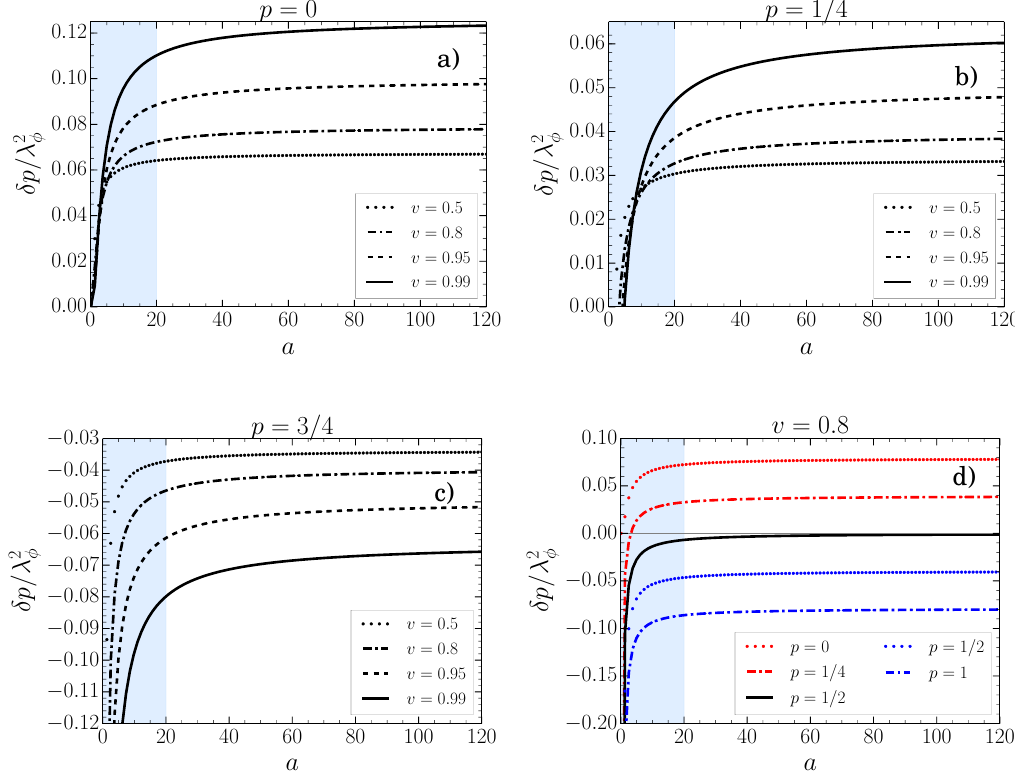
Figure 3. Behaviour of the change in probability for the linear scalar interaction, eq. (4.1), as a function of the reduced acceleration a = (cid:11)= (cid:10). Plots a), b), and c) show the e(cid:11)ect of increasing the velocity (e(cid:11)ectively the interaction time) on population change for a given initial excited population p . Plot d) shows the behaviour for a (cid:12)xed velocity as the velocity changes. The shaded blue region indicates where the perturbative approximation breaks